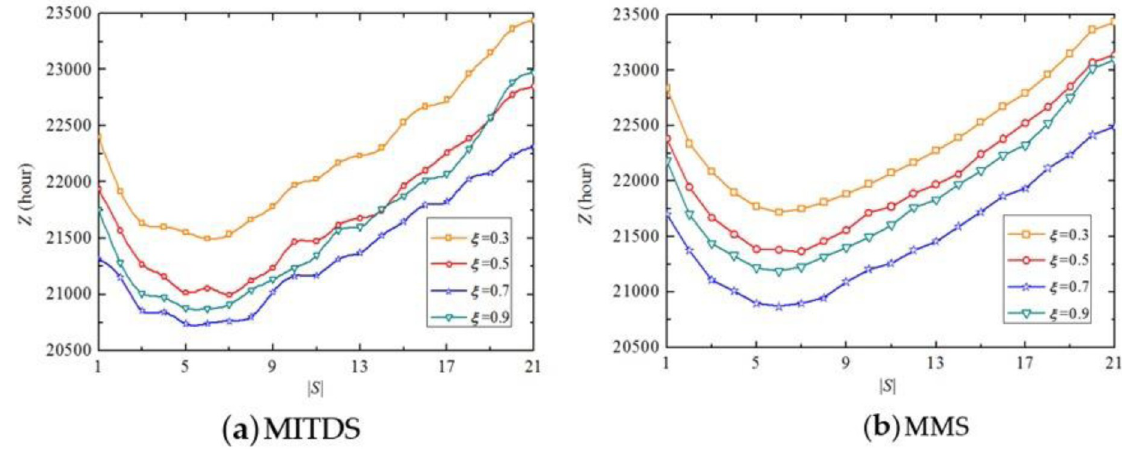
Fig 9. Impact of the parameter ξ on